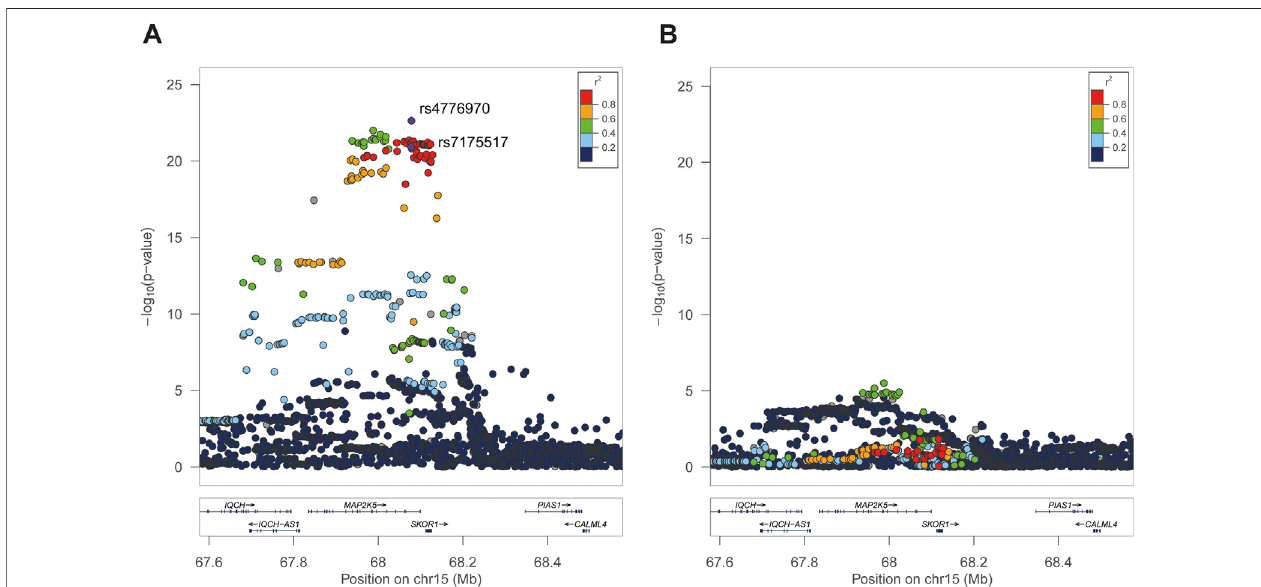
FIGURE 1 | Regional association plots of MAP2K5 loci independently associated with BMI in UKB. The Y -axis represents the p value on a -log10 scale, and the X -axis indicates the genetic variant localization. The r 2 was calculated based on rs7175517. (A) , The strongest association was SNP rs4776970 and rs7175517 via forwardstepwiseregressionanalysis. (B), AftertheconditionforSNPrs7175517andnoothersigni fi cantvariantwerepinpointed.Theextentoflinkagedisequilibriumfor all SNPs with rs7175517 is indicated by red